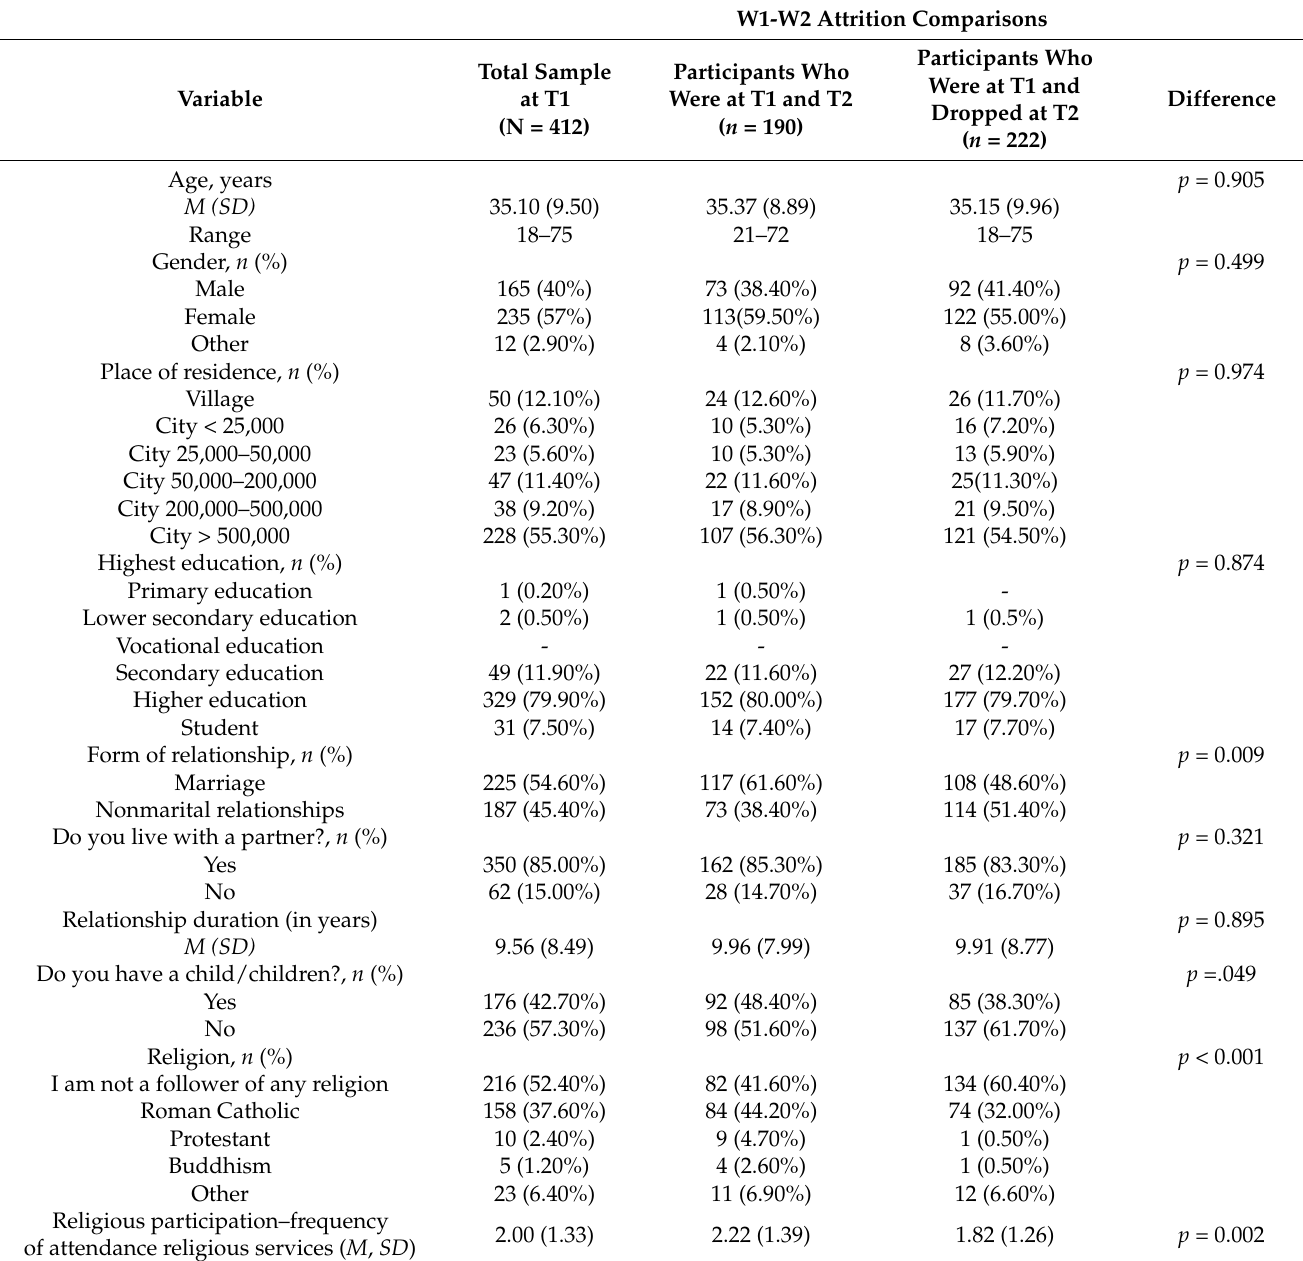
Table 4. Demographic Characteristics of Participants at T1 and T2 as a Function of the Attrition Rate between T1 and